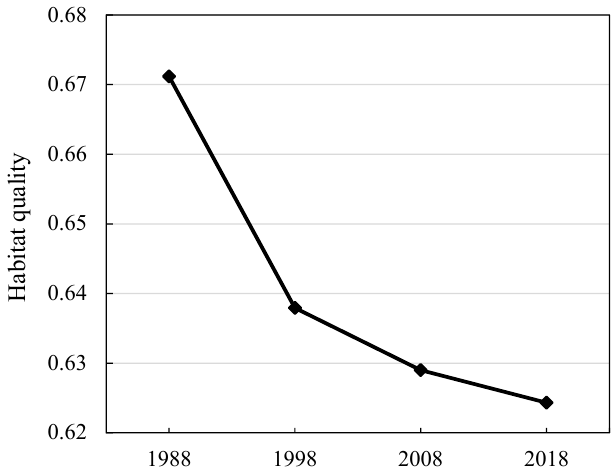
Figure 8. Habitat quality in the PLEEZ from 1988 to 2018.